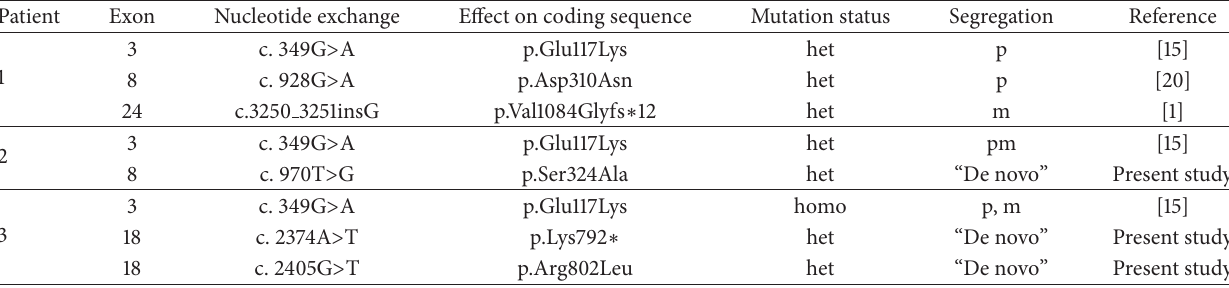
Table 1: NPHS1 mutations detected in the Vietnamese patients with CNS.